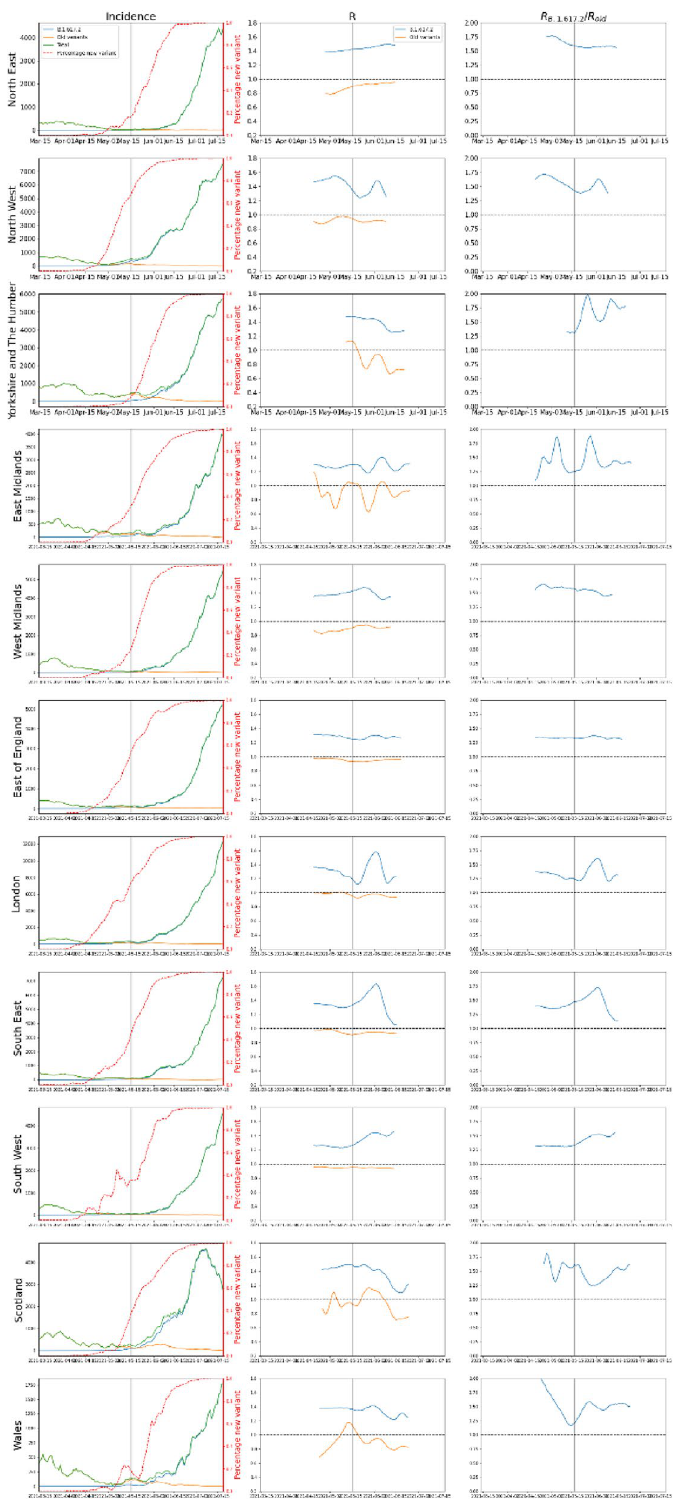
Figure 4. Incidence and R(t) for Delta and non-Delta variants. Left column shows total incidence, and incidence for each variant. Middle column shows R(t) for each variant. Rightmost column shows the ratio R_ Delta/R_non-Delta, noting that in the timeframe considered non-Delta was predominantly Alpha. Vertical line indicates lifting of some lockdown restrictions on May 17,